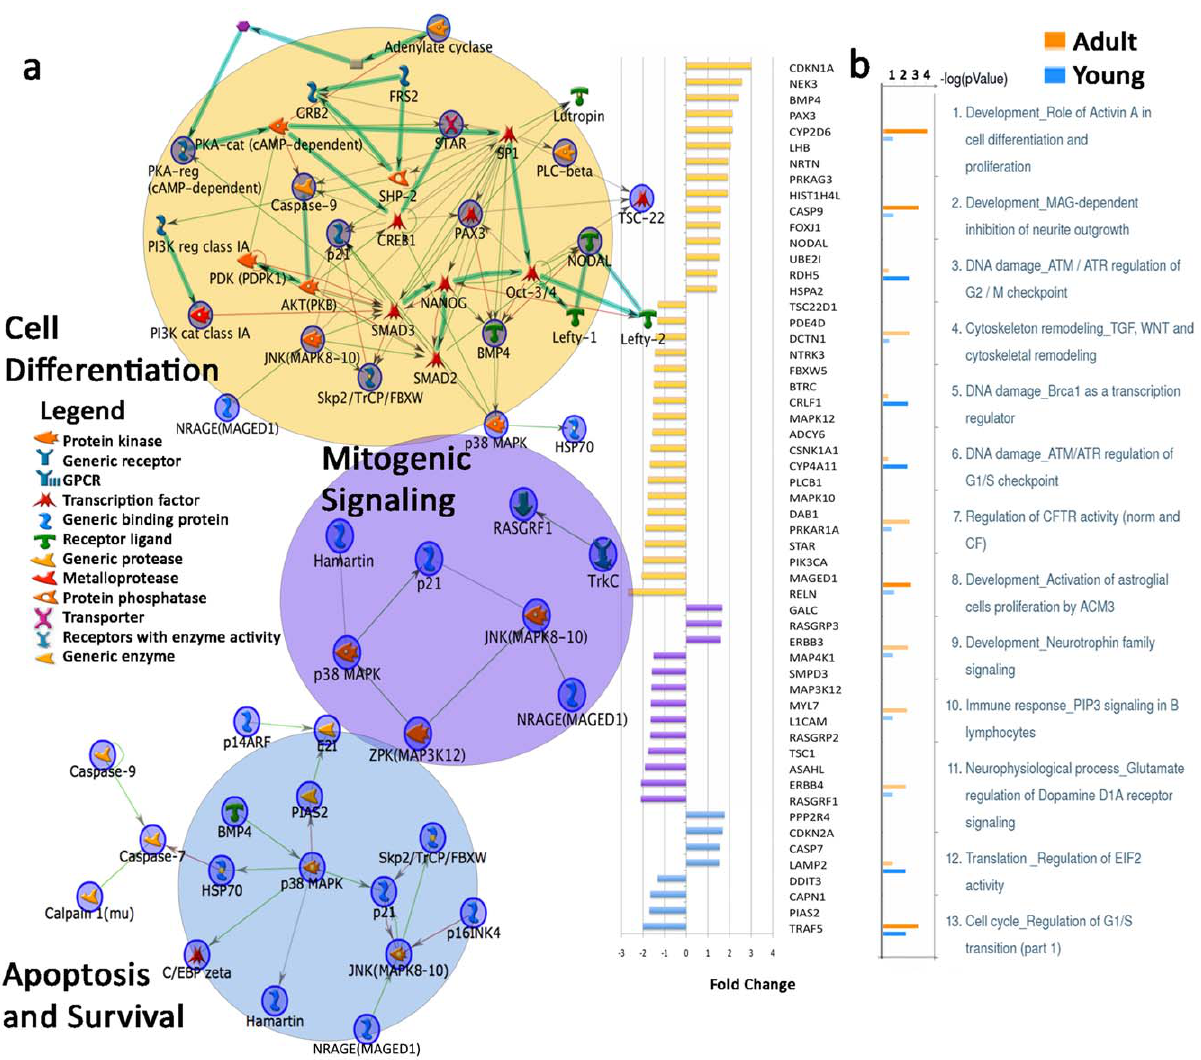
Figure 2. Dysregulated gene expression in top three Map Folders in adult autistic prefrontal cortex and differentially affected M- Pathways of young and adult autistic cases. (A) Graph on the right shows fold change of genes in cell differentiation, mitogenic signaling, and apoptosis and survival Map Folders. Colors on fold change graph correspond to circles on the left depicting network maps in each category. From each category of differentially expressed genes in adult autistic vs. adult control posthoc comparison (Table S4), gene networks on the left were created using MetaCore Network Analysis. (B) Top differentially affected M-pathway comparisons of dysregulated genes between adult and young autistic cases. Bars represent significance of listed pathways. Orange=adult; blue=young; faded color=FDR . 0.1 or p . 0.05.